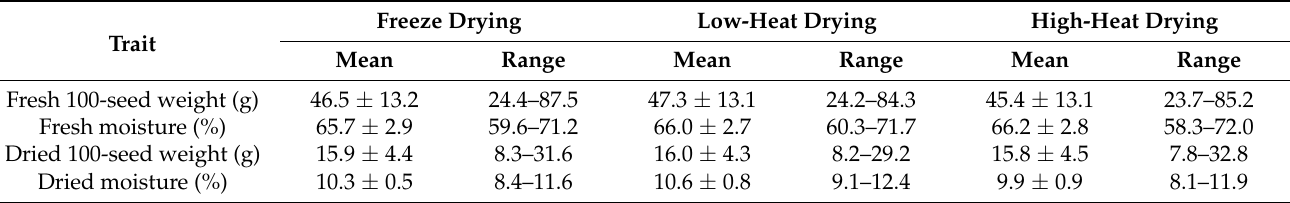
Table 2. Means ( ± sd) and ranges of variation of 100-seed weight and seed moisture of 20 soybean genotypes across three years